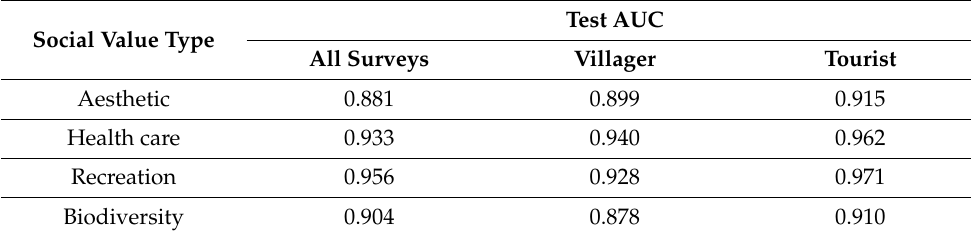
Table 4. Test AUC of each social value type in the Paifang rural community.